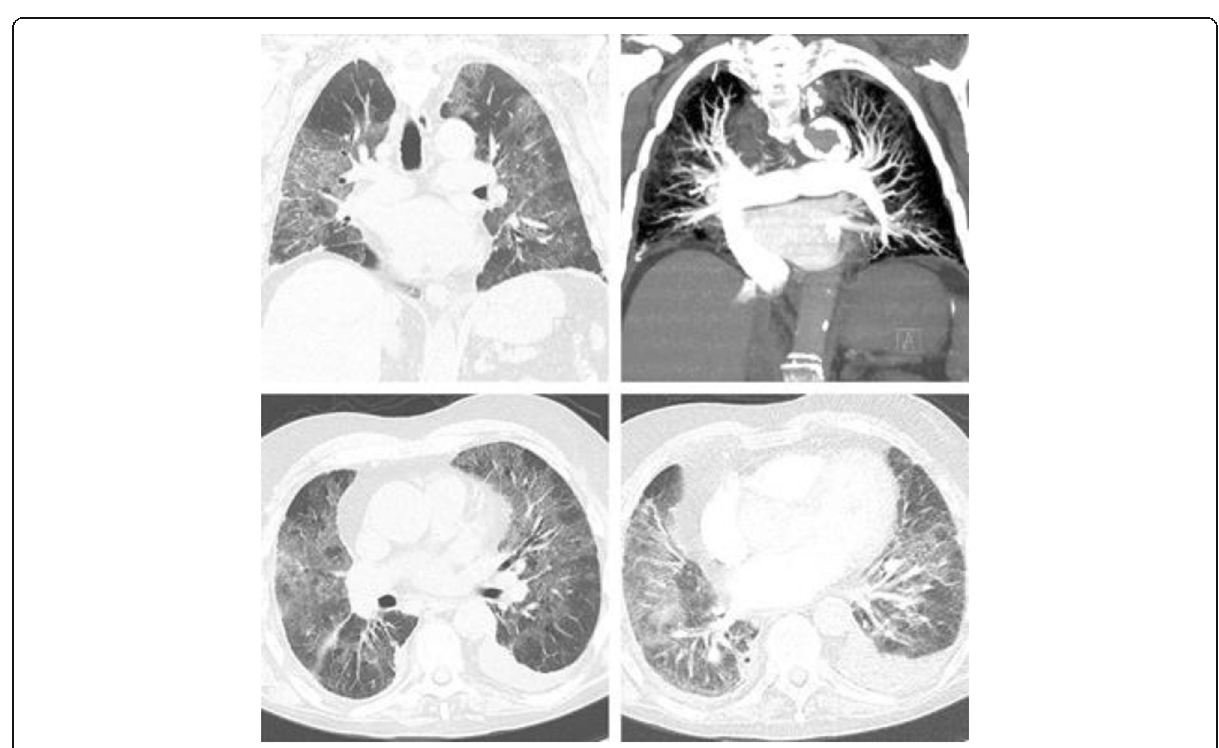
Fig. 4 Thorax CT-Scan showed multiple areas of ground-glass